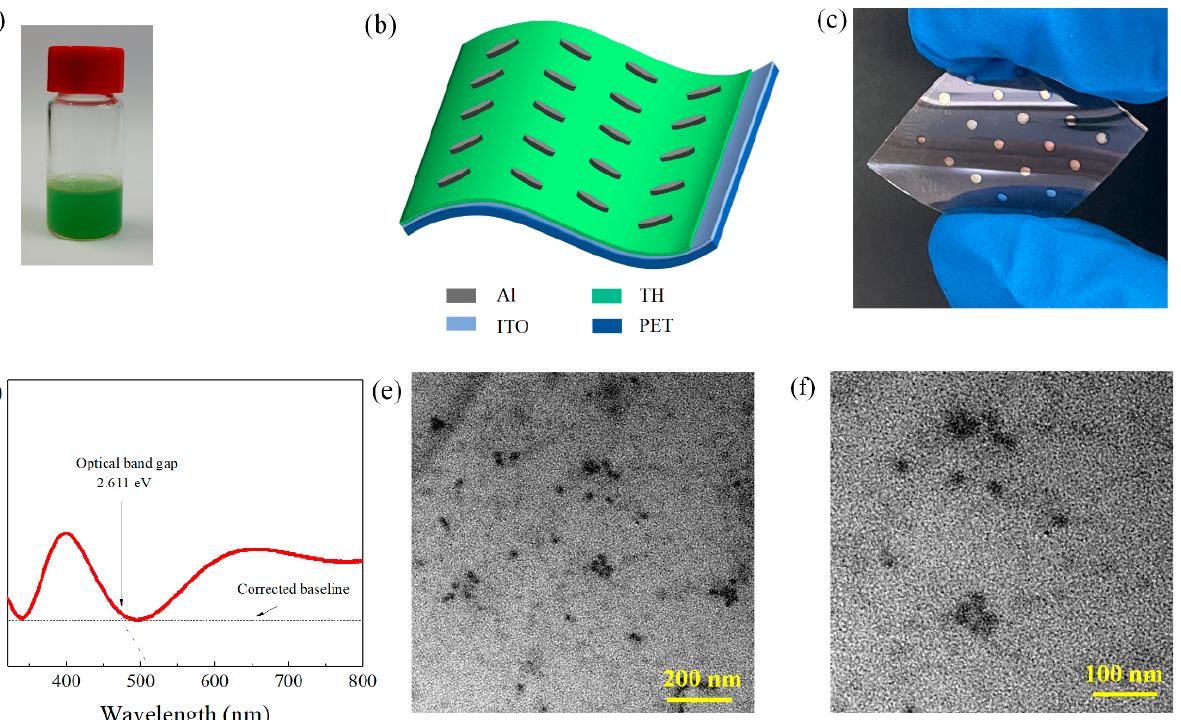
Figure 1. ( a ) TH directly obtained from silkworm larvae. ( b ) structure of the Al/TH/ITO/PET device. ( c ) photograph of the Al/TH/ITO/PET device. ( d ) UV-Vis absorption spectrum of TH. TEM images of TH magnified ( e ) 20,000 times and ( f ) 40,000 times.